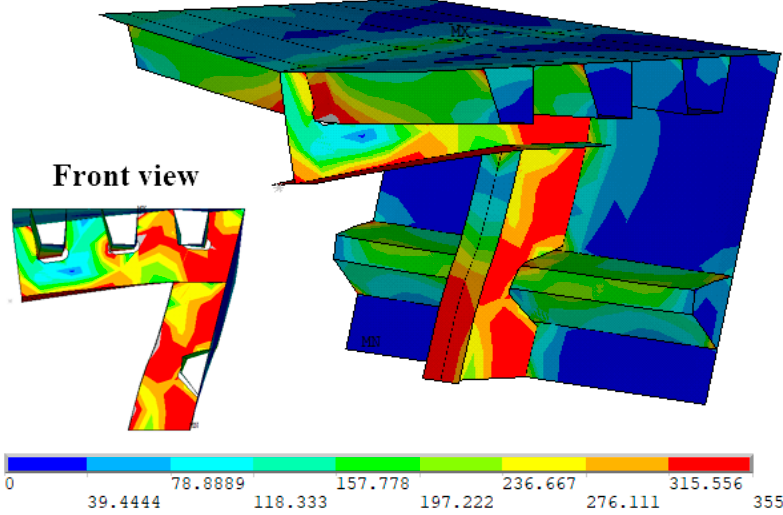
Figure 13. Failure mode (3D and front view)—von Mises stress distribution (units in (MPa)).